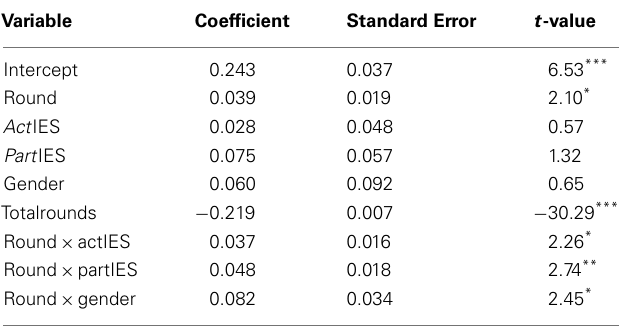
Table 5 | Fixed-effect solutions from the growth curve model (Study 4).